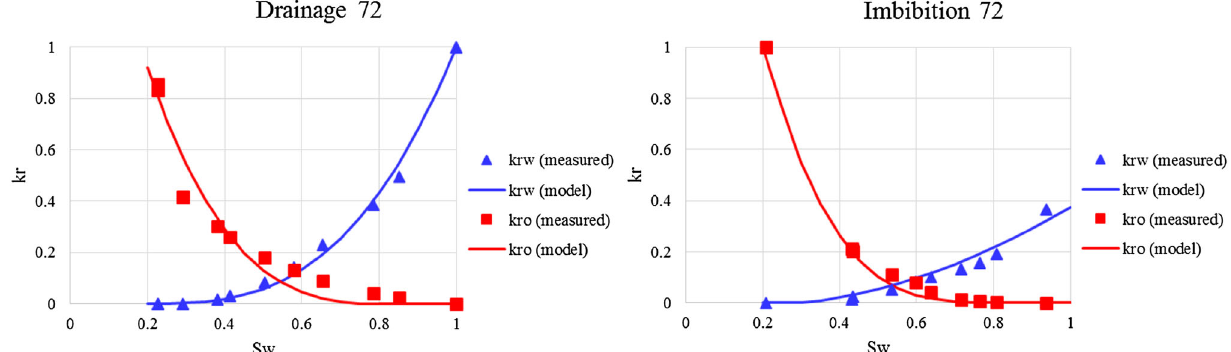
Fig. 15 Drainage and imbibition K r correlation for sample plug